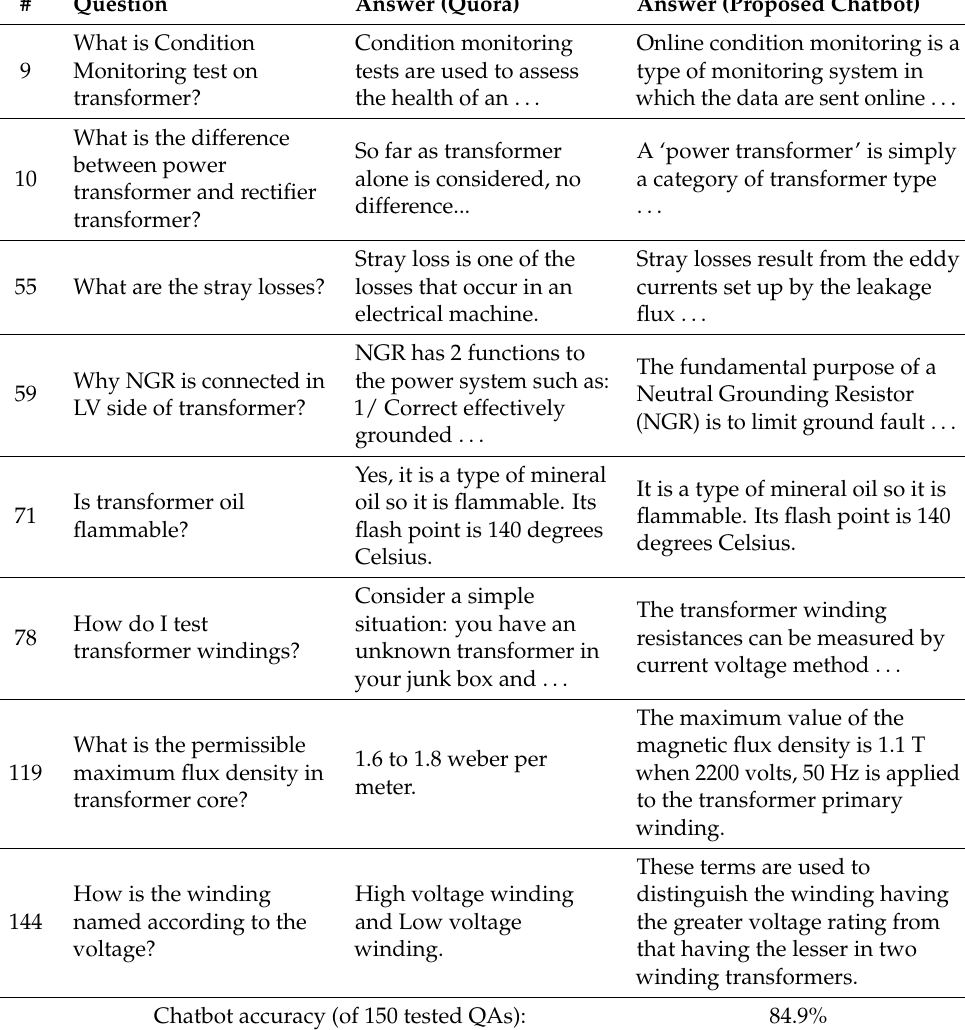
Table 5. Examples of Quora test